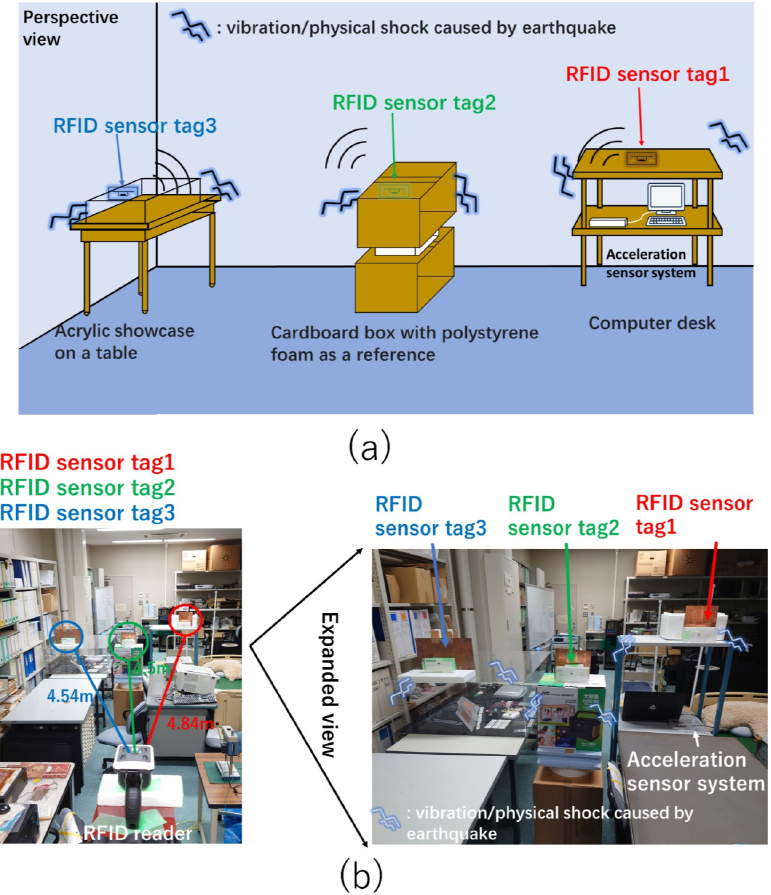
Figure 5. Experimental environment. ( a ) The perspective view of the three RFID sensor tags. ( b ) Photo of the experimental